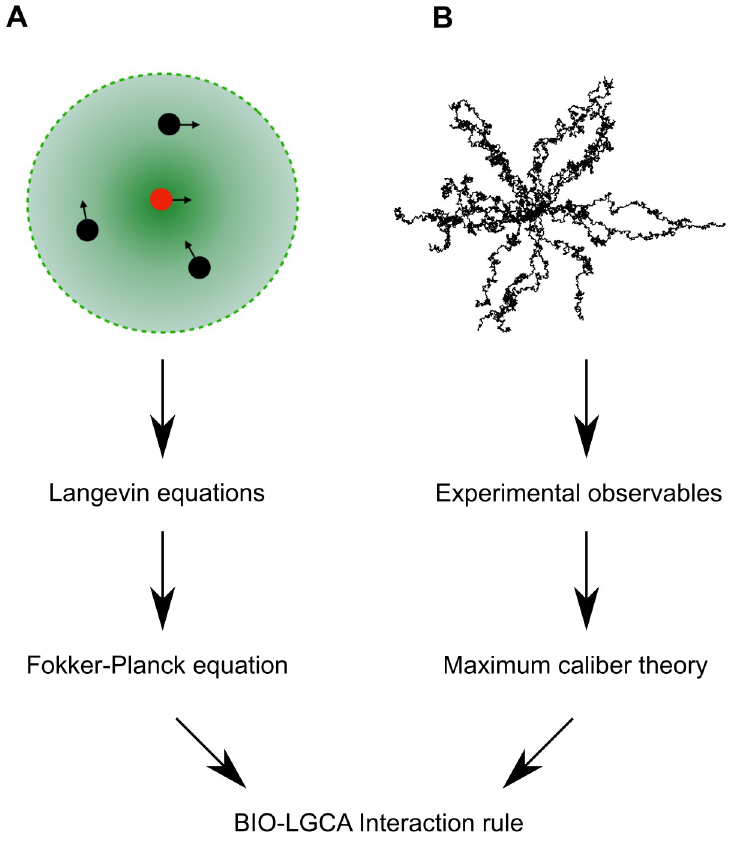
Fig 4. Rule generation in BIO-LGCA models. A: Starting from the Langevin equations of a self-propelled particle model, the interaction rule can be obtained from the steady-state distribution of the associated Fokker-Planck equation. B: Alternatively, experimental observables can be used as input for the maximum caliber theory to derive the probabilities of cell tracks and the corresponding interaction rule.